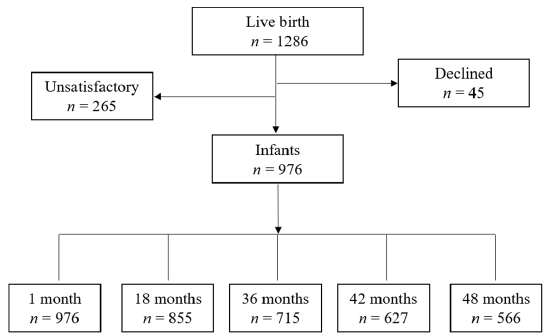
Figure 1. Participant study flow.